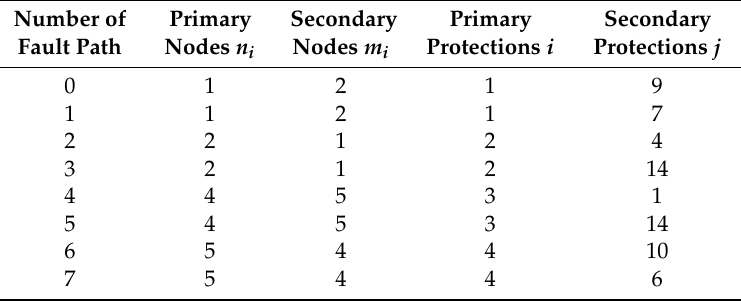
Table 3. IEEE 6-bus power system fault